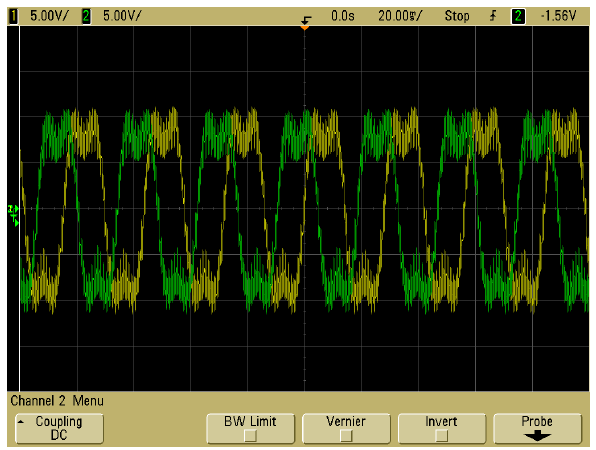
Figure 8. Phase voltages u a and u b at a speed of 700 rpm.